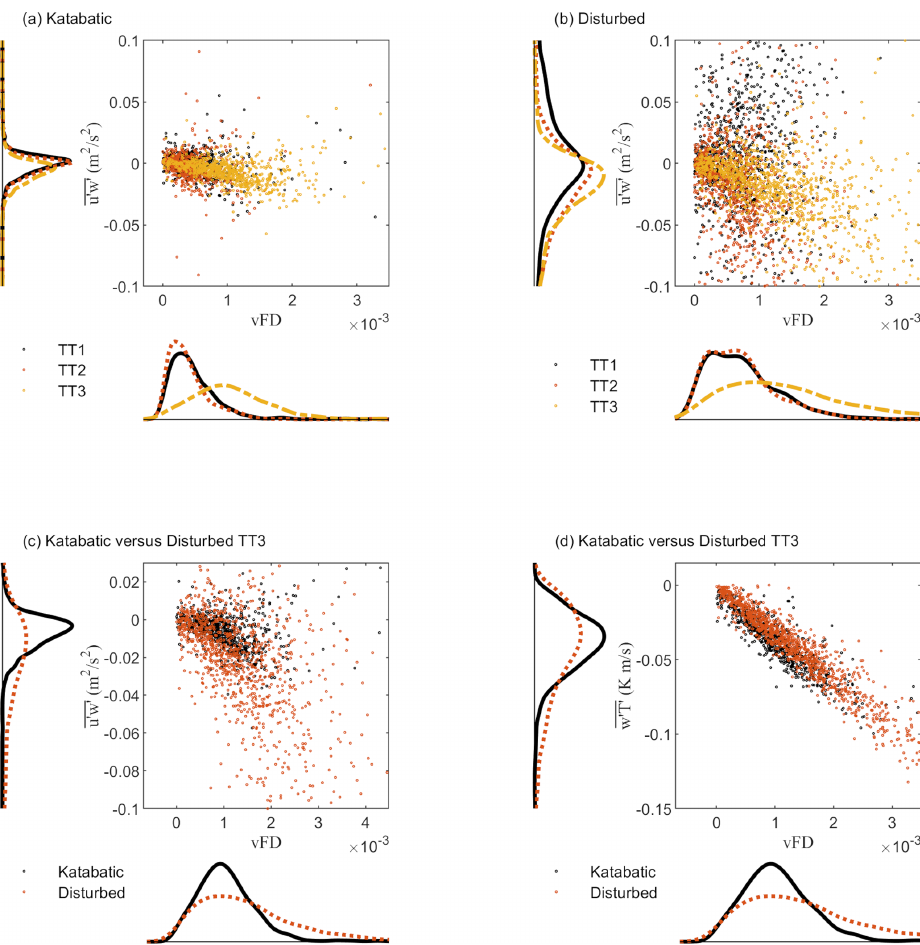
Figure 11. Vertical flux divergence plotted against streamwise momentum flux for stations TT1, TT2, and TT3 is shown for katabatic (a) and disturbed conditions (b) . To allow a better comparison of fluxes during different flow conditions, the vertical flux divergence (vFD) is plotted against streamwise momentum flux (c) and against vertical turbulent heat flux (d) for station TT3 for katabatic and disturbed